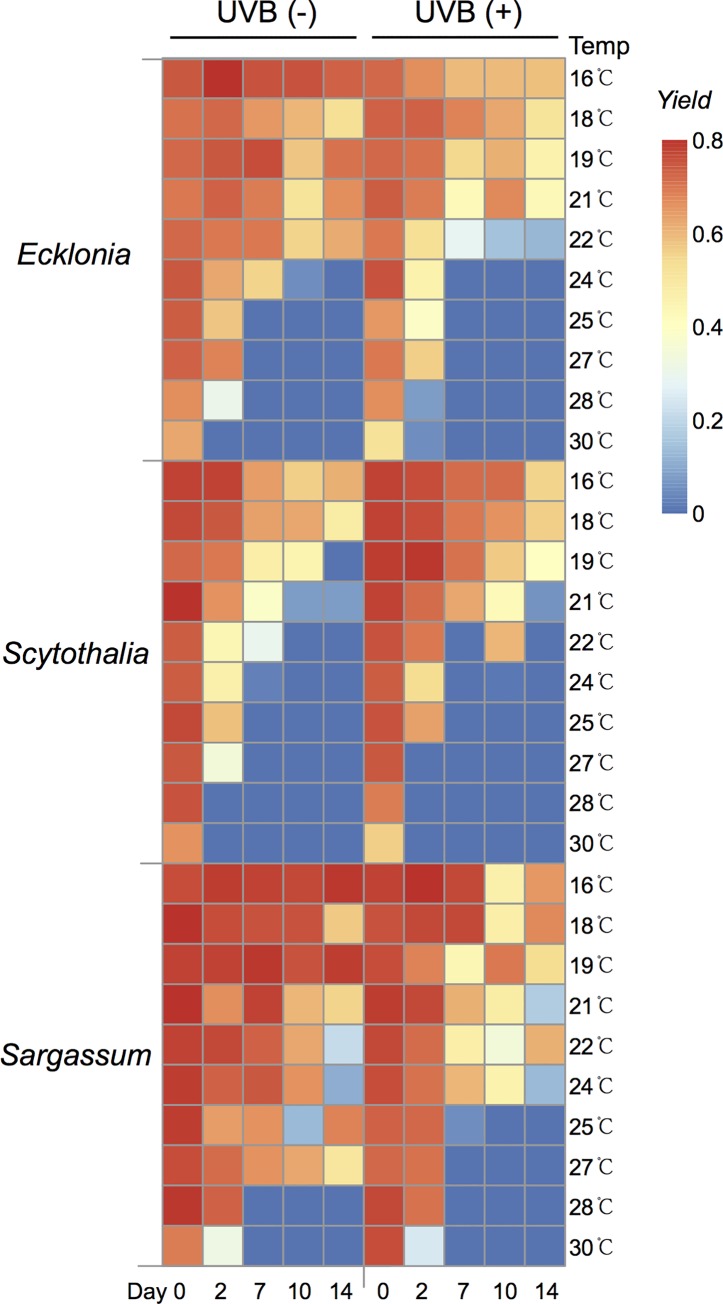
Maximum quantum yield of dark adapted Ecklonia, Scytothalia and Sargassum after 0, 2, 7, 10 and 14 days of cultivation at temperatures from 16 to 30°C, left: no UVB radiation; right: under UVB radiation.